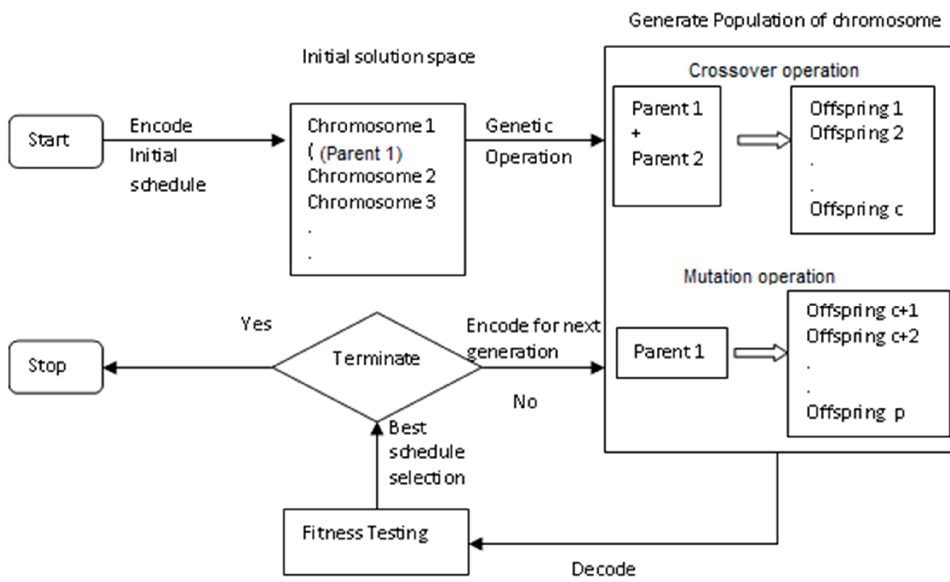
Figure 5. Procedure to set the initial schedule using a genetic algorithm.